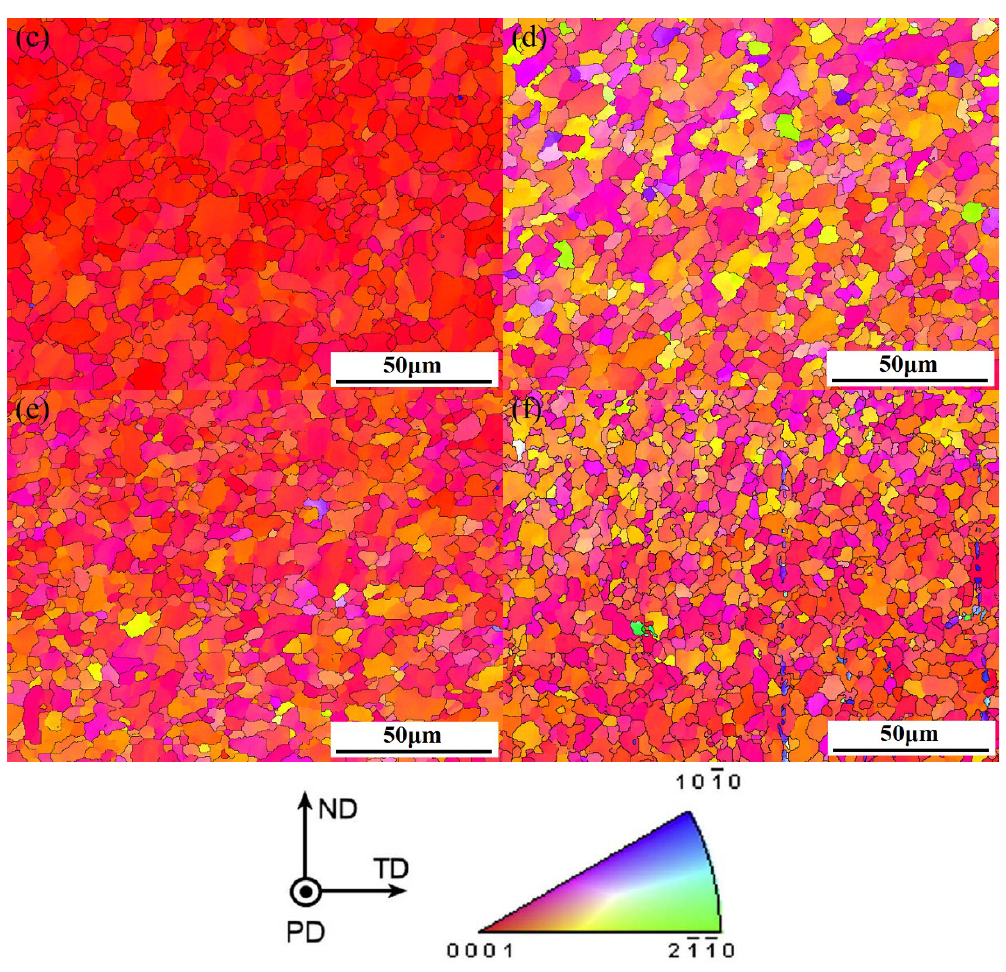
Figure 5. Inverse pole figure maps of different SZ regions in FSP Mg–6Sn–2Zn samples: ( a ) SZ-up region at 60 mm/min; ( b ) SZ-down region at 60 mm/min; ( c ) SZ-up region at 90 mm/min; ( d ) SZ-down region at 90 mm/min; ( e ) SZ-up region at 120 mm/min; and ( f ) SZ-down region at 120 mm/min.